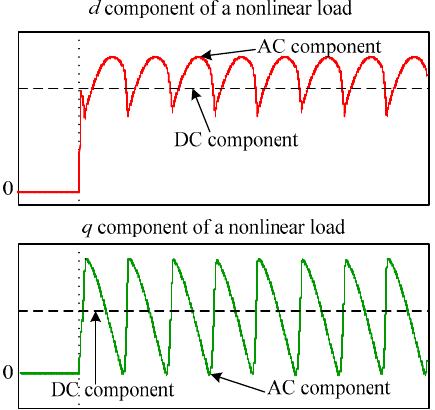
Figure 3. dq waveforms for nonlinear signals.